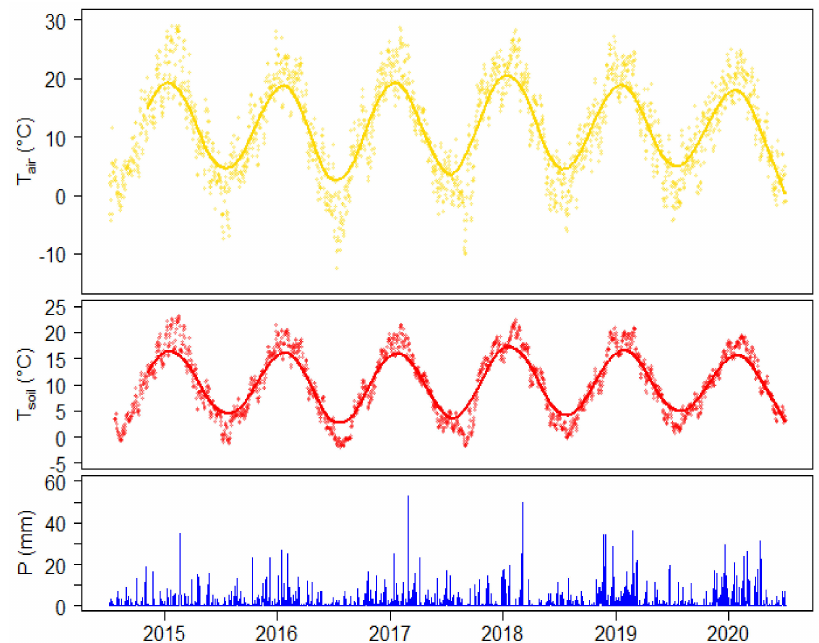
Figure 2. Time series of daily mean air temperature (T air ), soil temperature (T soil ) and daily sums of precipitation (P) over the whole study period at the study site Lanžhot, Czech Republic. The lines in the uppermost two panels indicate local polynomial regression fittings (loess; span = 0.1).